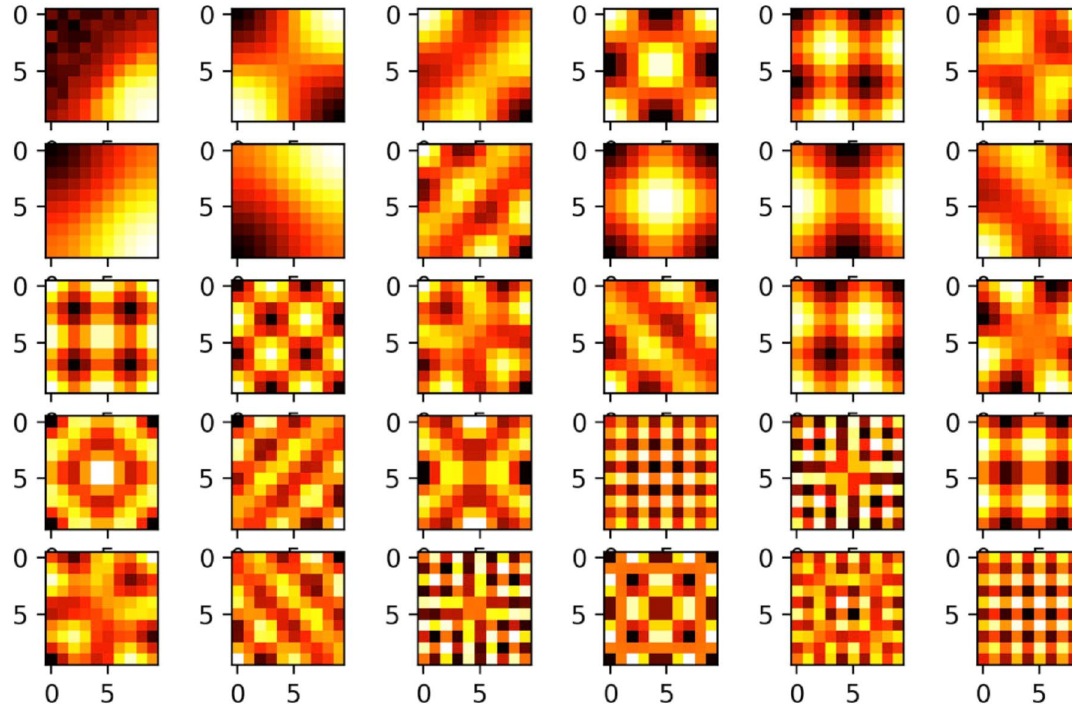
Figure 4. Grid cell-like Eigenvectors of the SR matrix: The firing patterns of grid cells in the entorhinal cortex are proposed to represent the Eigenvectors of the SR matrix 32 . For the squared room depicted in Fig. 3, the Eigenvectors for the first 30 Eigenvalues of the SR matrix are shown (re-shaped to the shape of the squared environment). Indeed, they resemble grid cell-like firing patterns. Furthermore, the grids vary in orientation and scaling, as observed in electrophysiological experiments in